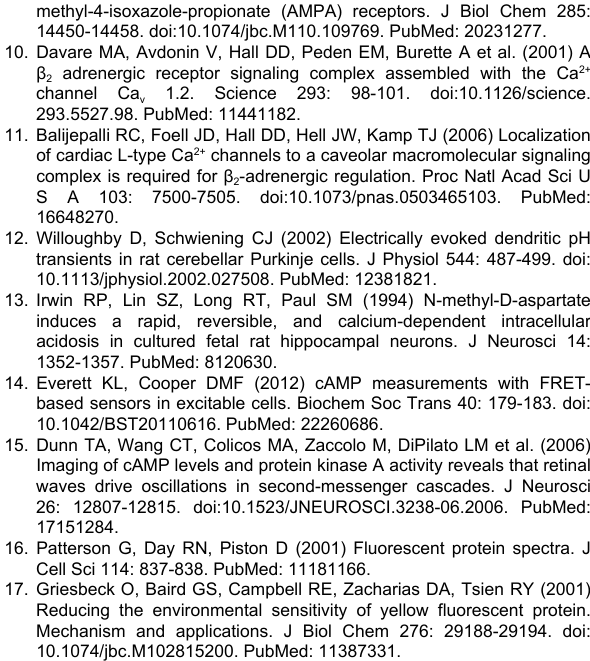
Figure S4. Single cell data for Ca 2+ and cAMP measurements in cells expressing VGCCs. Cells